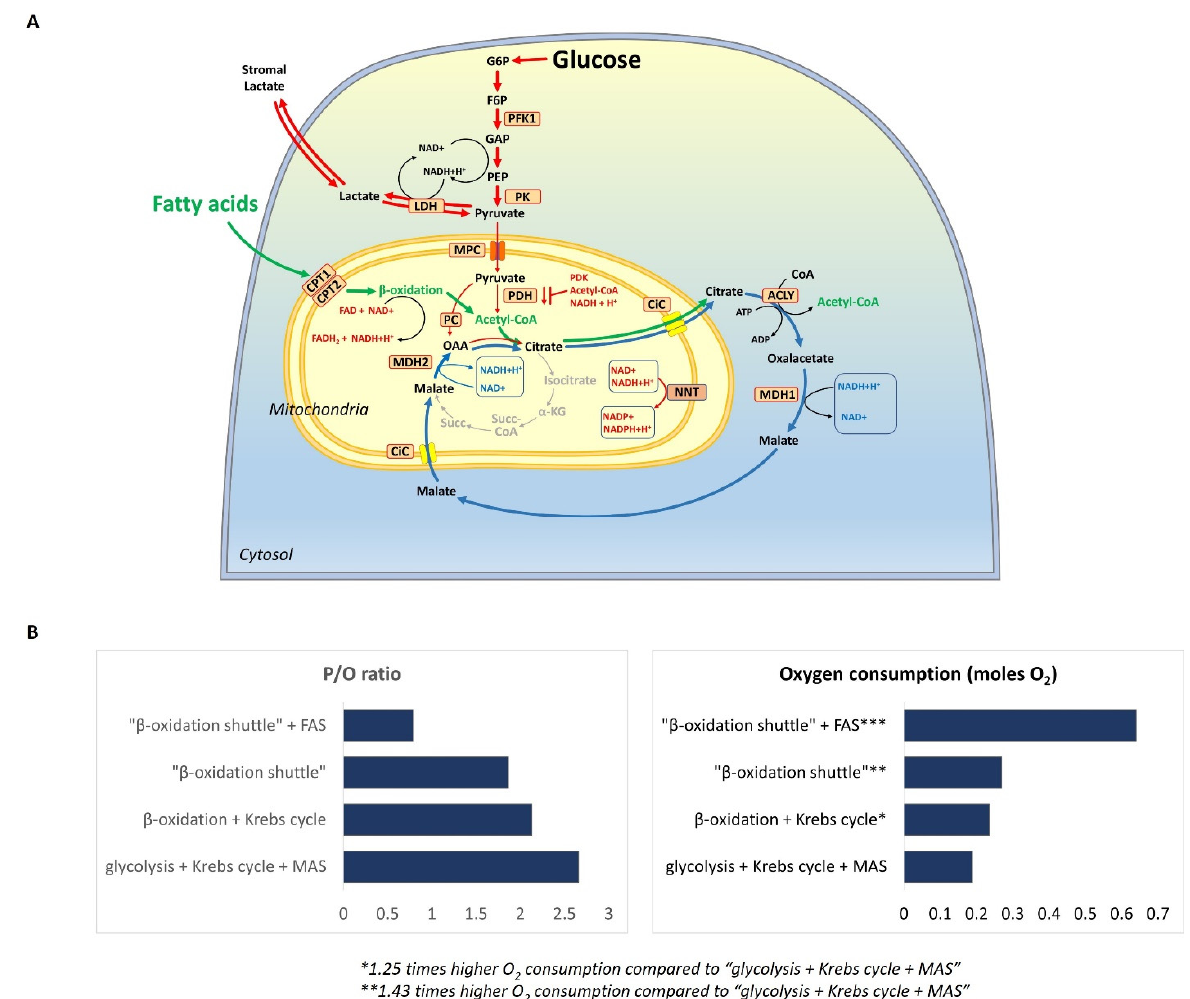
Figure 2. ( A ) Schematic representation of the “ β -oxidation shuttle” in mitochondria: the relation between β -oxidation, the citrate–malate shuttle, and the formation of a separate and independent metabolic pathway, which has its own energy efficiency, own oxygen consumption, and own influence on other metabolic pathways. The green arrows indicate the metabolic flux from fatty acids. The red arrows indicate the metabolic flux from glucose. The red blunt ends indicate the inhibition of a particular enzyme. The blue arrows indicate the citrate-malate shuttle. ( B ) Phosphate/oxygen (P/O) ratio and oxygen consumption in the combustion of glucose and palmitate in the “ β -oxidation shuttle” and other metabolic pathways—a comparison. Abbreviations: ACLY: ATP citrate lyase; CIC: mitochondrial citrate carrier; CTP1 and CTP2: carnitine palmitoyl transferases 1 and 2; F6P: fructose-6-phosphate/fructose-1,6-bisphosphate; G6P: glucose-6-phosphate; GAP: glyceraldehyde-3-phosphate; α -KG: α -ketoglutarate; MAS: malate–aspartate shuttle; MPC: mitochondrial pyruvate carrier;